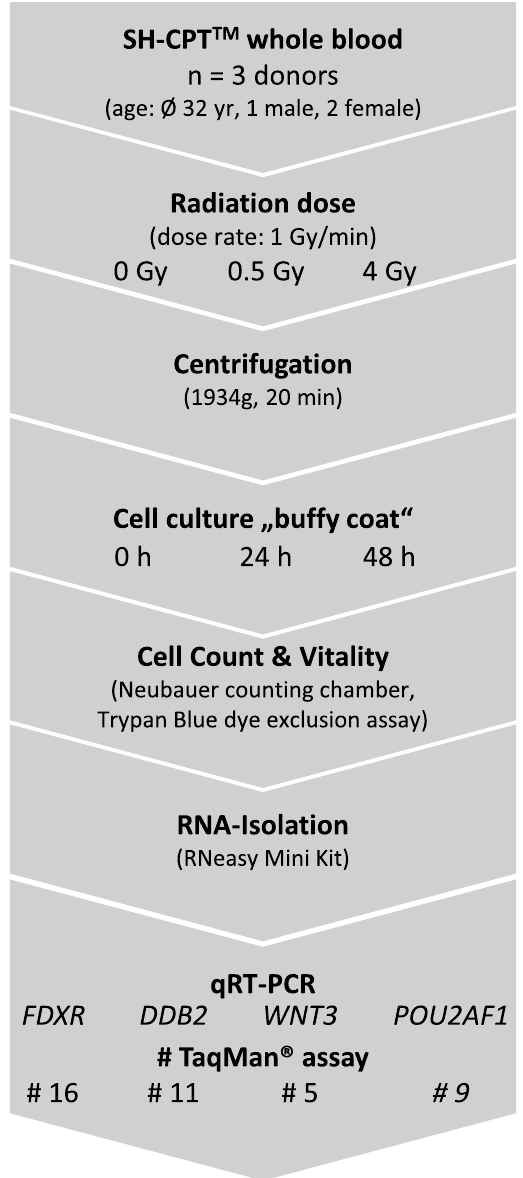
Figure 1. Study overview. Study design overview including X-irradiation of SH-CPT blood, centrifugation to isolate PBMCs, in vitro culture, cell count and viability measurements, RNA isolation and gene expression measurements with TaqMan assays covering all exon-regions of FDXR, DDB2, WNT3 and POU2AF1 . SH-CPT = Cell Preparation Tube with Sodium Heparin. PBMC = peripheral blood mononuclear cells. Ø = average age of donors. # = number of TaqMan